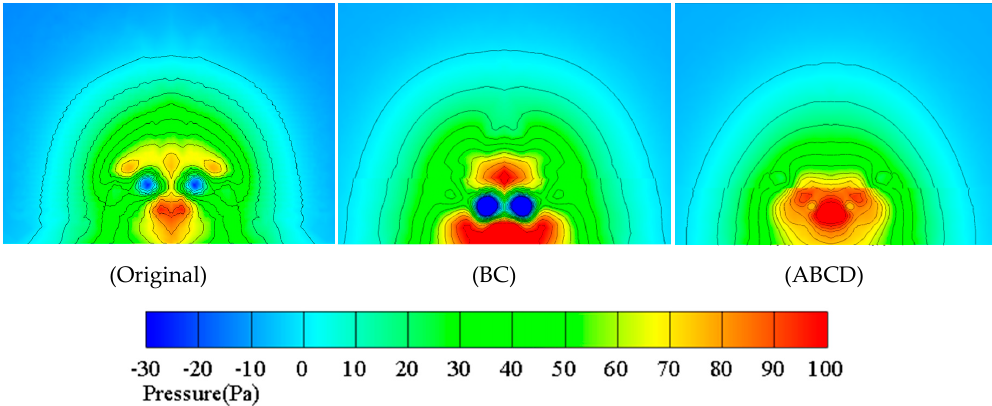
Figure 15. Pressure contour on x = 0.6 m section (15 kV).